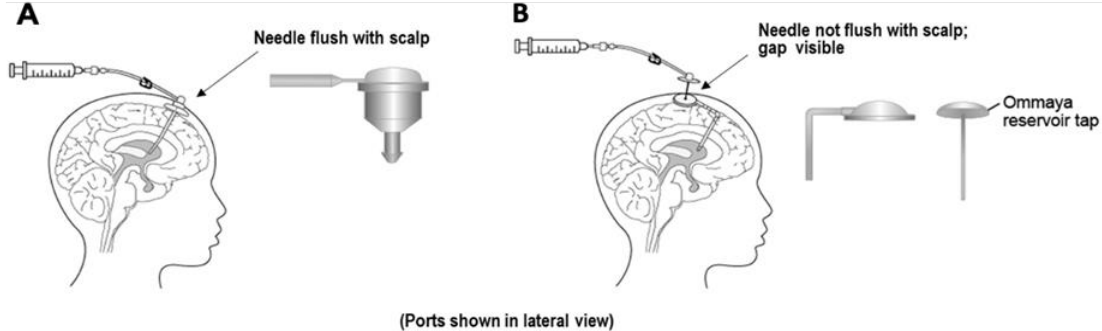
Figure 4. Illustration of intraventricular administration by ( A ) Rickham reservoir and ( B ) Ommaya reservoir. Reproduced with permission from [225], Elsevier, 2020.